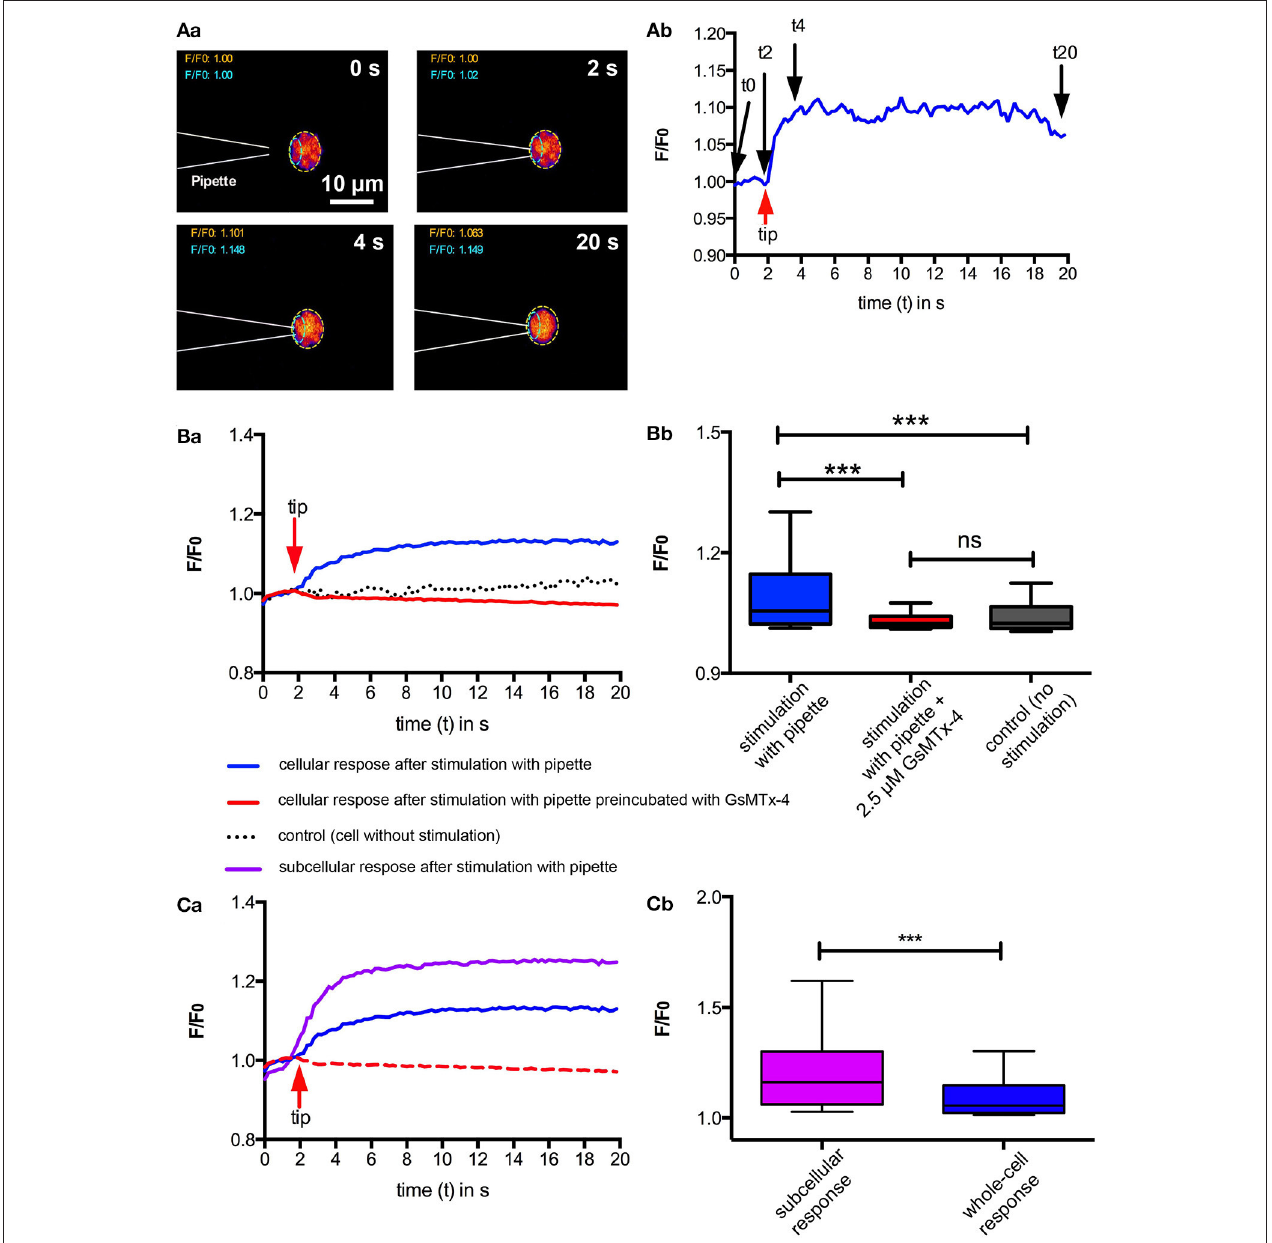
FIGURE 2 | Ca 2 + -signaling of RBC after local mechanical stimulation. Individual RBCs were mechanically stimulated using a micropipette. (A) exemplifies a typical experiment. Fluorescent confocal images of a Fluo-4 loaded cell when touched by a micropipette at four time points are shown in (Aa) . The color scale is the same as in Figure 1Aa . Since the pipette is not visible in the fluorescent image, its position is drawn in the images by dashed white lines. The fluorescence intensity (F/F 0 ) of the region of interest (ROI) indicated by the dashed yellow line in (Aa) is plotted in (Ab ) indicating the time point when the pipette touches the cell (red arrow) and the time points of the images displayed in (Aa) (black arrows). (B) depicts the statistical analysis comparing pipette stimulation in the absence and presence of GsMTx-4 with unstimulated RBCs. For each condition between 74 and 76 cells from three different donors were analyzed. The median fluorescence trace (F/F 0 ) over time of all cells is depicted in (Ba) . The red arrow indicates the time point when the pipette was touching the RBC. The analysis of the cellular maximal response (F/F 0 ) is depicted in (Bb) . The response of the mechanical stimulation in the absence of GsMTx-4 is significantly different relative to all other conditions measured ( p < 0.001; ***). (C) Compares the cellular response of 76 RBCs as depicted in (B) with the local (subcellular) fluorescence intensity at the spot where the micropipette is touching the cell as indicated by the ROI outlined with cyan dashed lines in (Aa) . The median fluorescence trace (F/F 0 ) over time of all cells is depicted in (Ca) . The red arrow indicates the time point when the pipette was touching the RBC. For a better comparison the blue and the red lines are replotted from (Ba) . The comparison of the local (subcellular) and cellular (whole-cell) maximum response (F/F 0 ) is depicted in (Cb) . The local response is significantly higher than the whole-cell response ( p < 0.001;